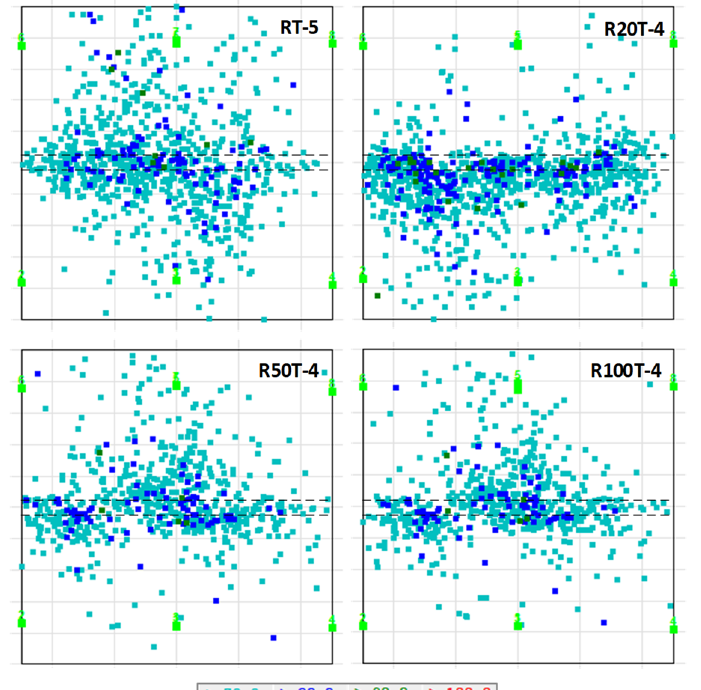
Figure 14. Projection of the location of all events with an amplitude above 70 dB for RT ‐ 5, R20T ‐ 4, R50T ‐ 4 and R100T ‐ 4. The location of the notch is indicated by dashed lines and the position of AE sensors are indicated by light green